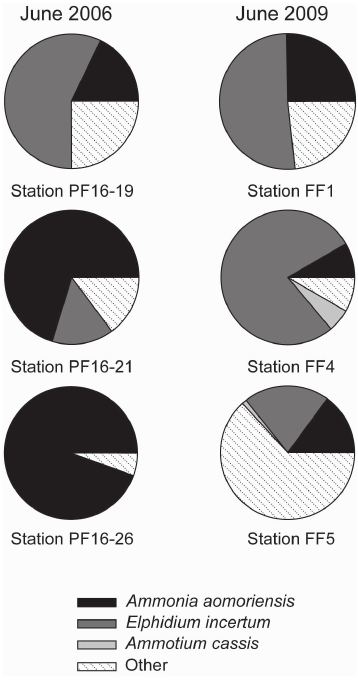
Fig. 8. Comparison of living benthic assemblages between the years 2006 and